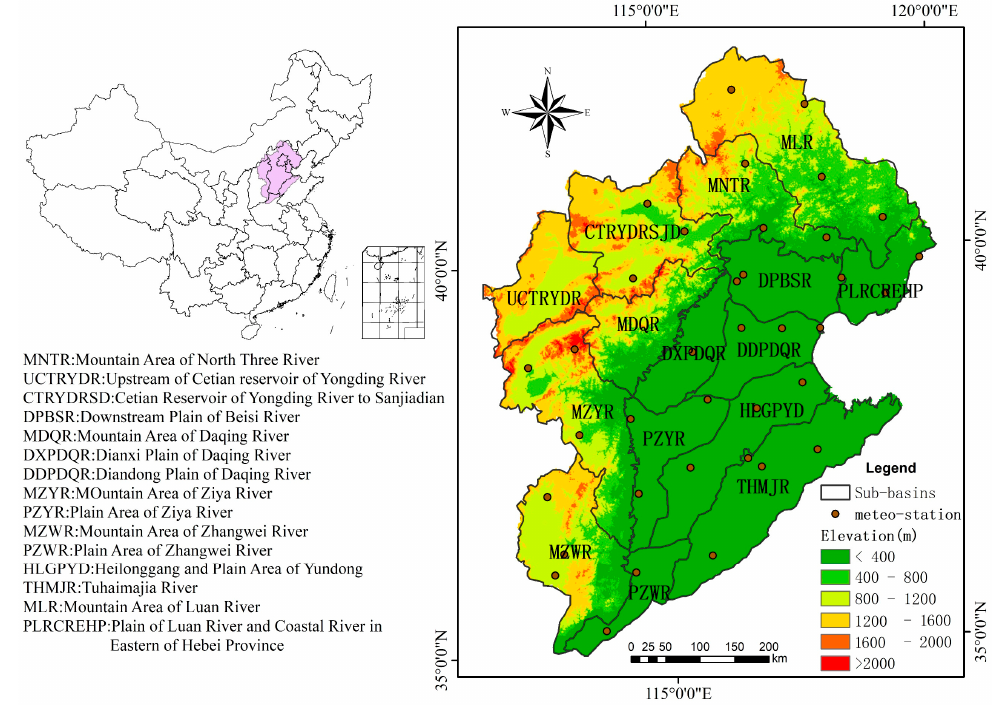
Figure 1. Location of Hai Basin, its subbasins, meteorological stations, and elevation.